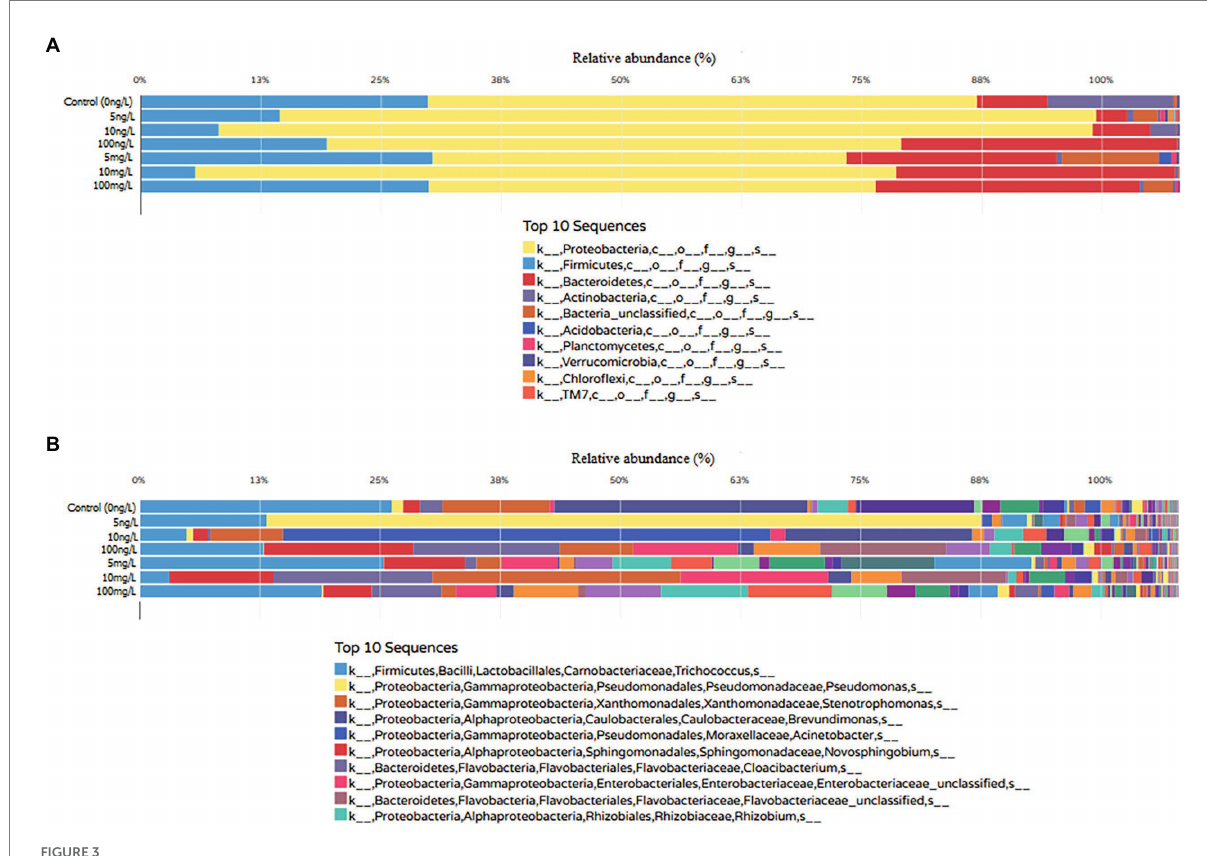
FIGURE 3 Relative abundance and phylum-level (A) and genus-level (B) taxonomic classification of 16S rRNA amplicons across sequenced samples [environmental (5, 10, and 100 ng/L) and predictive elevated concentrations (5, 10, and 100 mg/L)] against the SILVA prokaryotic reference database. The x-axis shows the different EE2 concentrations while the y-axis shows the relative abundance in percentage of identified phylum and genus of the top 10